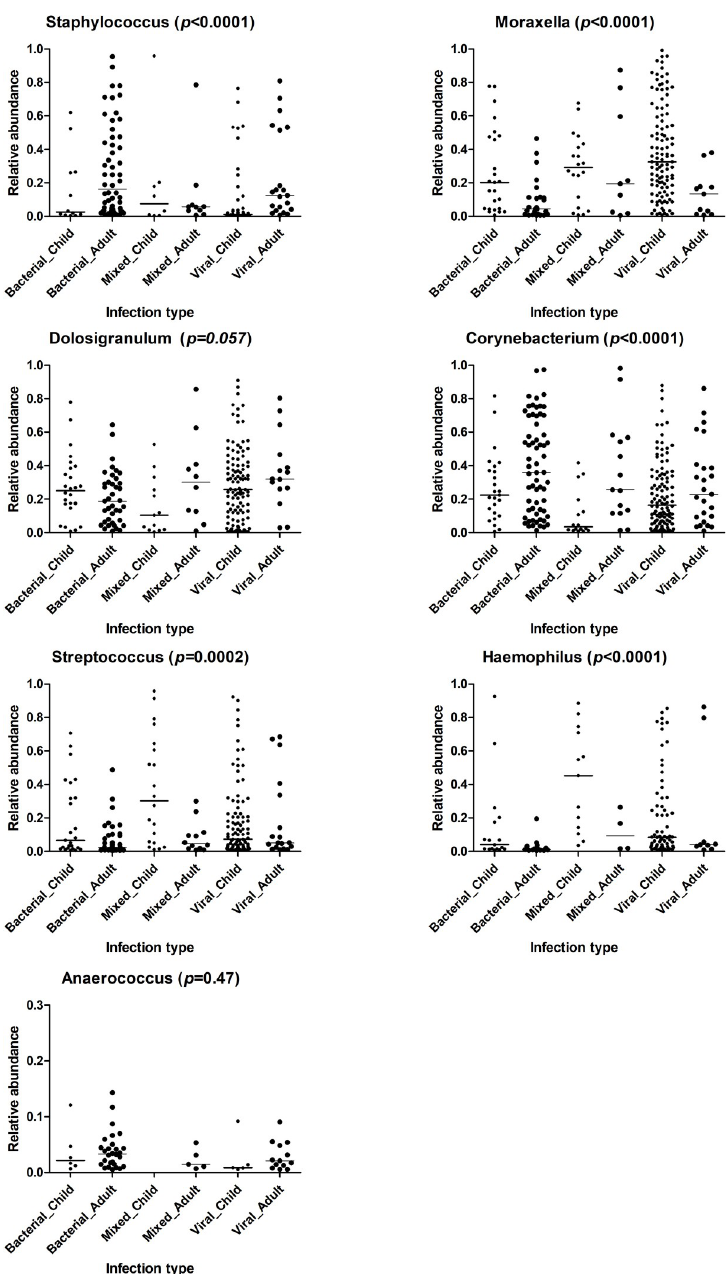
Fig 3. Relative abundance of seven most common bacterial genera related to age and infection origin of TAILORED-Treatment cohort. Kruskal-Wallis test was performed to calculate the p -values. Horizontal bars represent the median